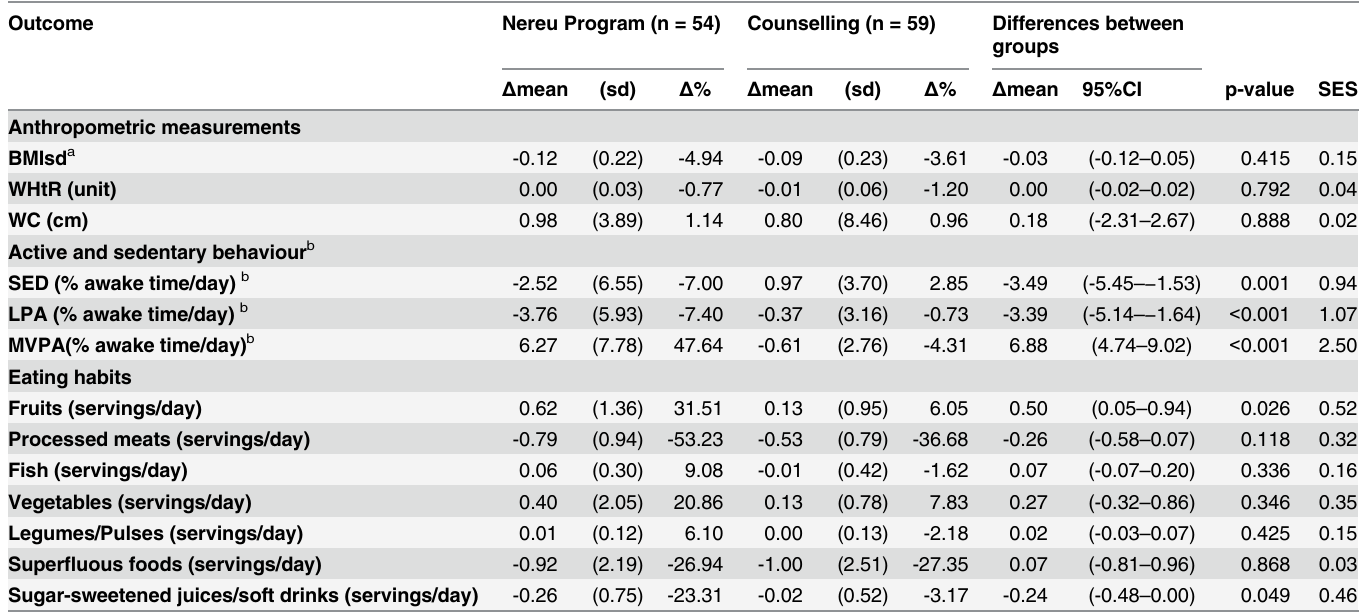
Table 2. Pre-post Intervention Differences in Main Outcomes between Nereu Program (NP) and Counselling Group (CG). Outcome Nereu Program (n =